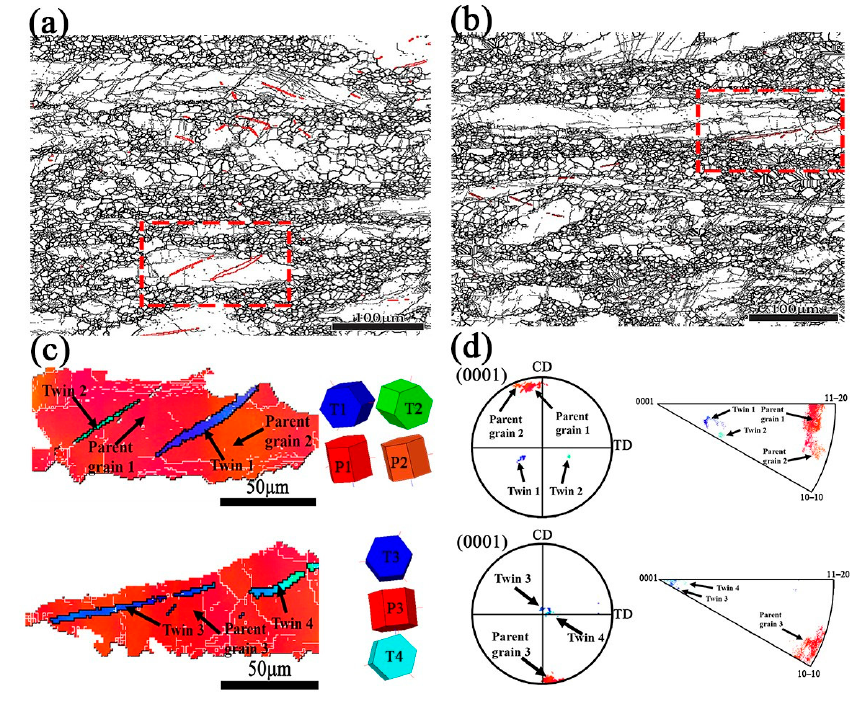
Figure 16. Grain boundary maps showing twinning under 573 K with strain rate ( a ) 0.01 s − 1 , ( b ) 0.1 s − 1 , ( c ) intercept region about crystal orientation in ( a , b , d ) corresponding (0001) PFs and IPFs in ( c ), respectively.